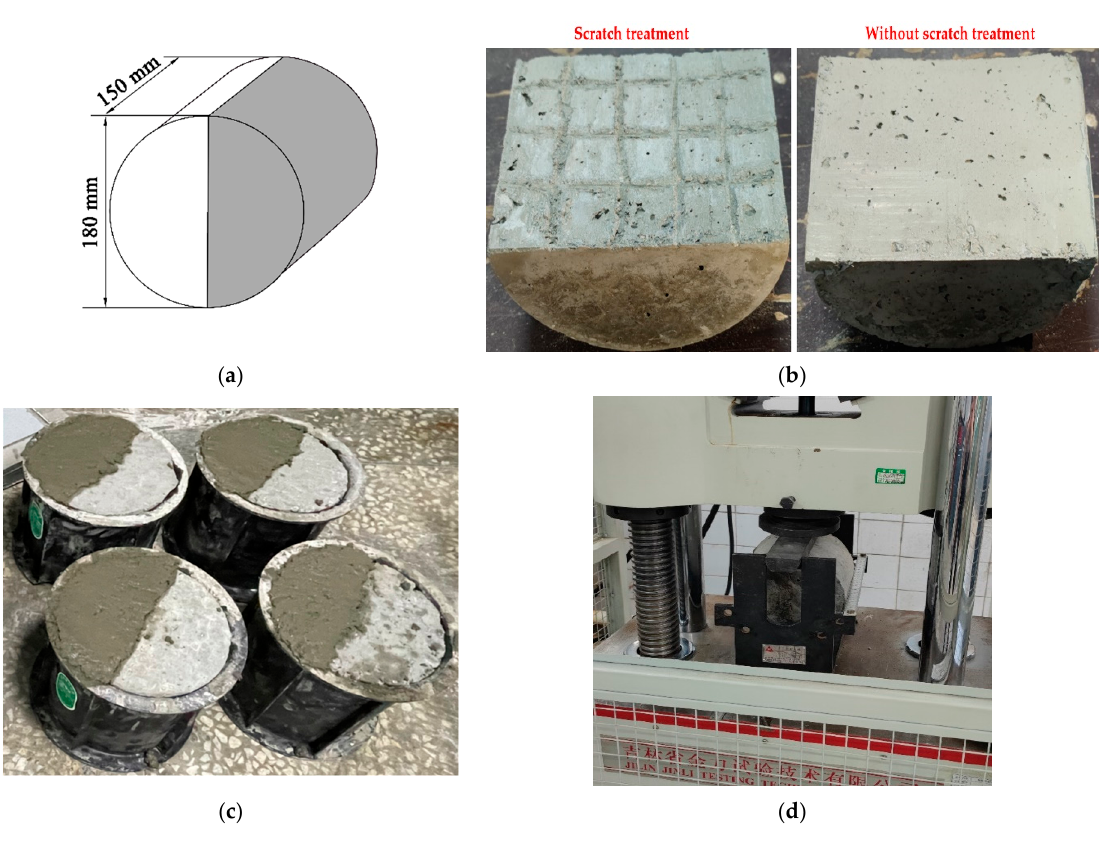
Figure 5. The split tensile test flow. ( a) Specimen geometry; ( b ) Concrete interfacial scratching treatment; ( c ) Casting; ( d ) Loading.